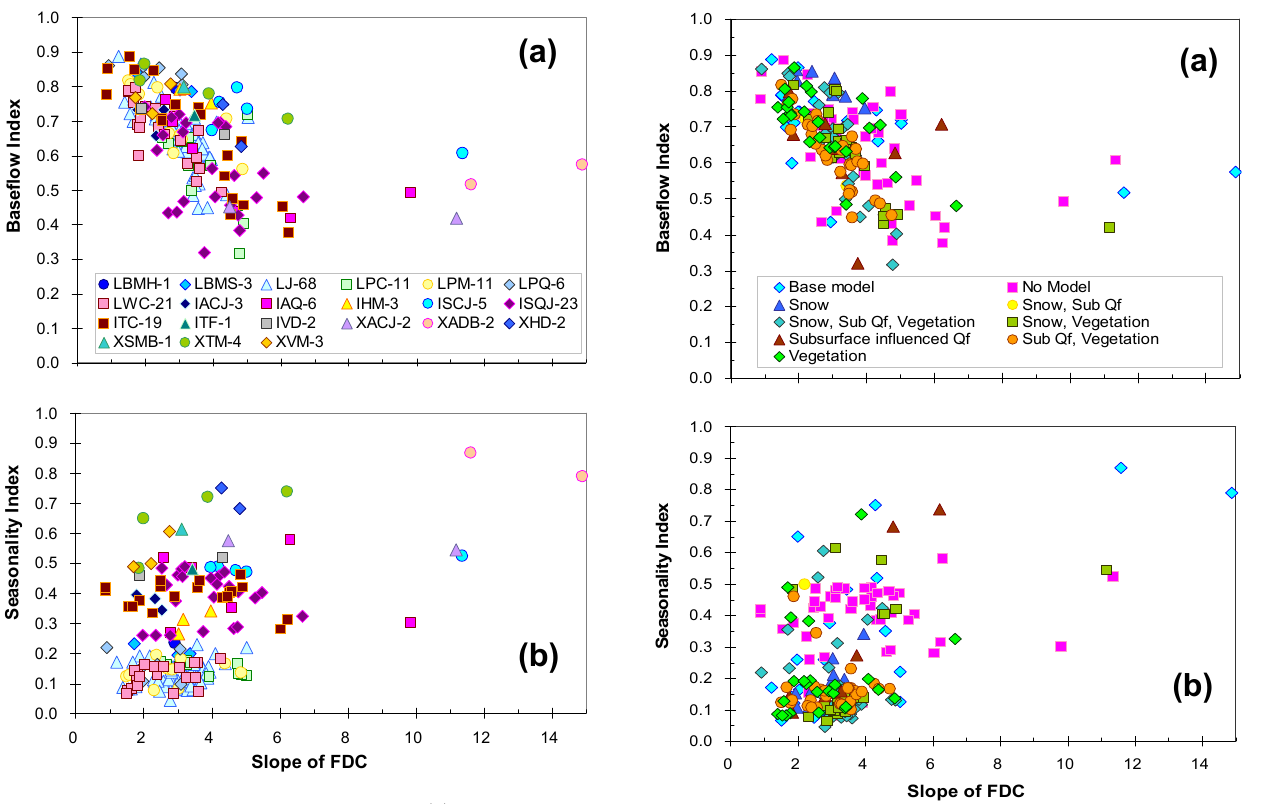
Fig. 10. Relationship between baseflow index (a) and seasonality index (b) and total streamflow FDC slopes (grouped by catchment class).